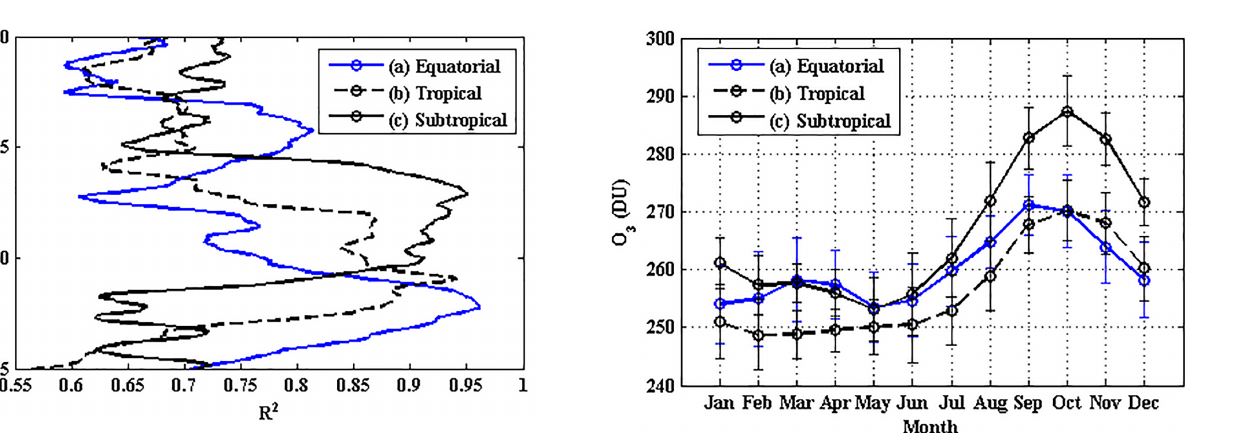
Figure 7. Seasonal variations of total ozone over three different re- gions: equatorial (a), tropical (b) and subtropical (c) regions. Error bars represent ± 1 σ